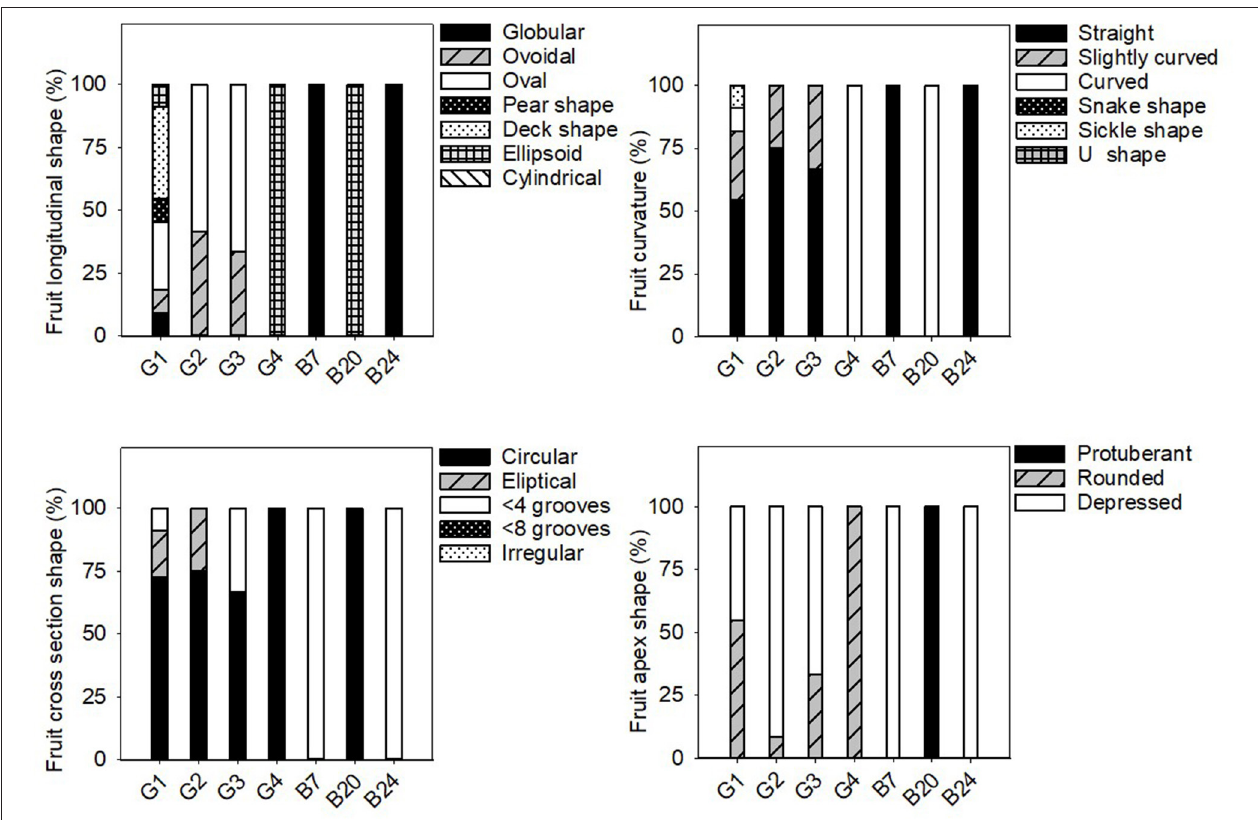
FIGURE 4 | Frequency distribution (%) of the fruit qualitative traits related to fruit shape and size in the 31 eggplant landraces in each group (G1, G2, G3, G4) and B7, B20, and B24. Measurements were taken when fruits reached the commercial maturity. Data for fruit traits were measured from 10 different fruits which were representative of the